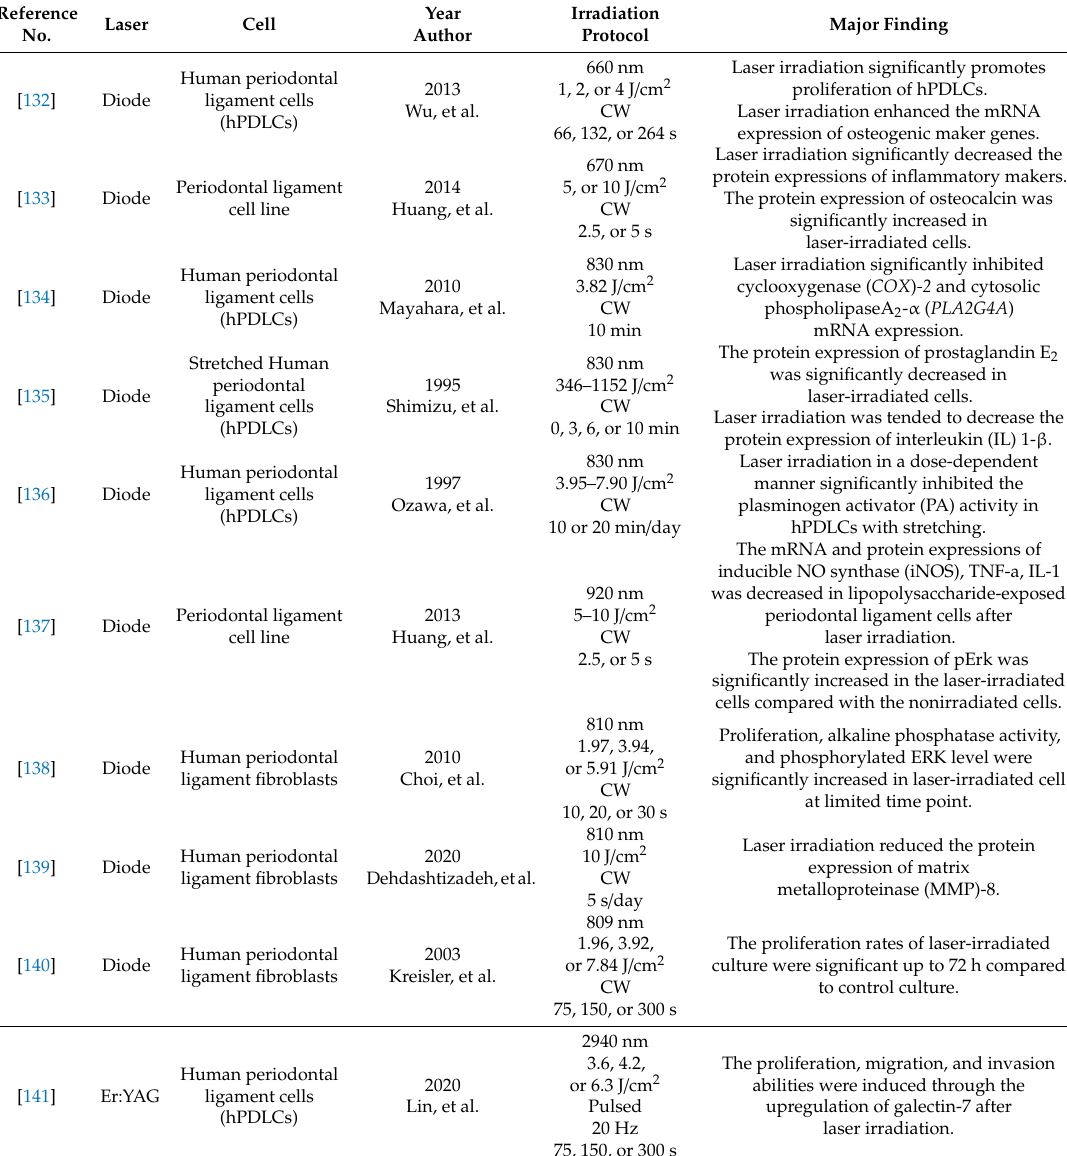
Table 3. Summary of the e ff ects of laser irradiation on human periodontal ligament cells. Reference